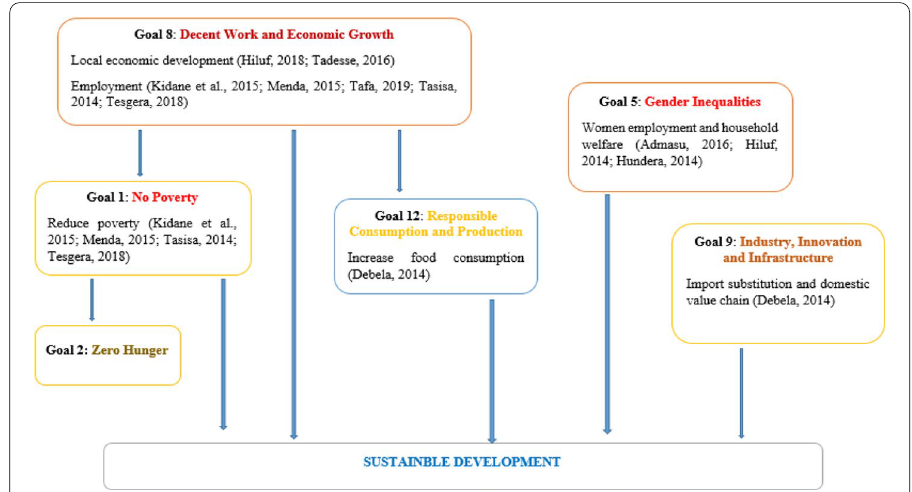
Fig. 2 Framework on MSMEs contribution to sustainable development. Source: own sketch based on literature